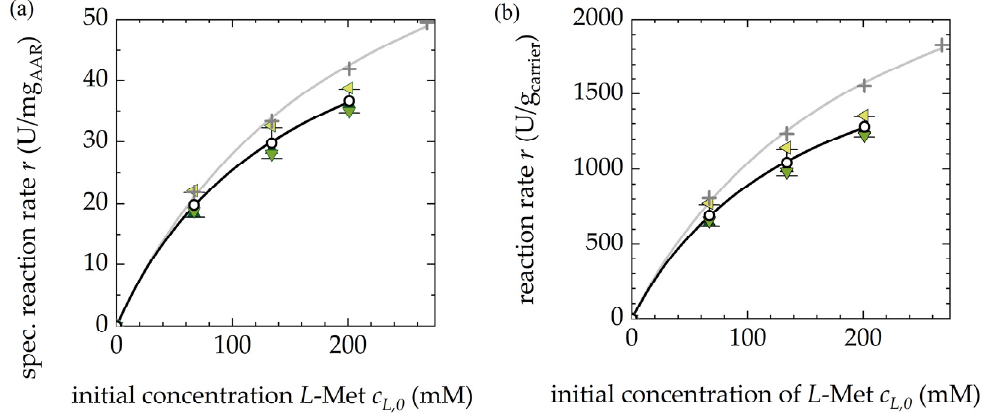
Table 2. Kinetic parameters of immobilized amino acid racemase (AAR) from two batches in pure water for L -Met, Equation (1).